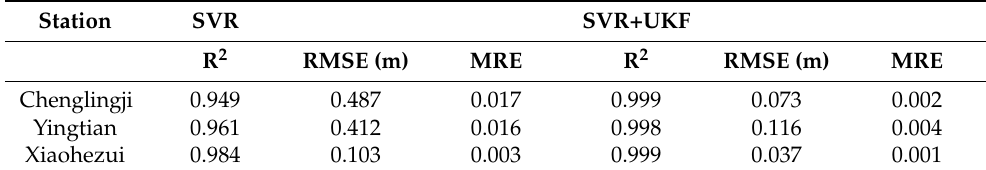
Table 4. Performance comparisons between peak water levels with SVR and SVR+UKF. Station